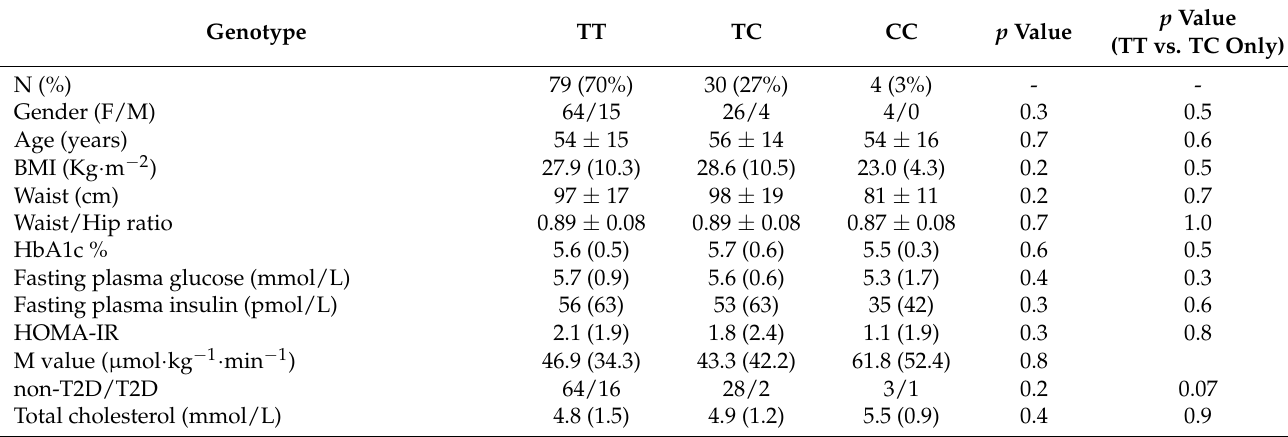
Table 1. Anthropometric and biochemical characteristics of the study participants by rs17782313 genotype *.